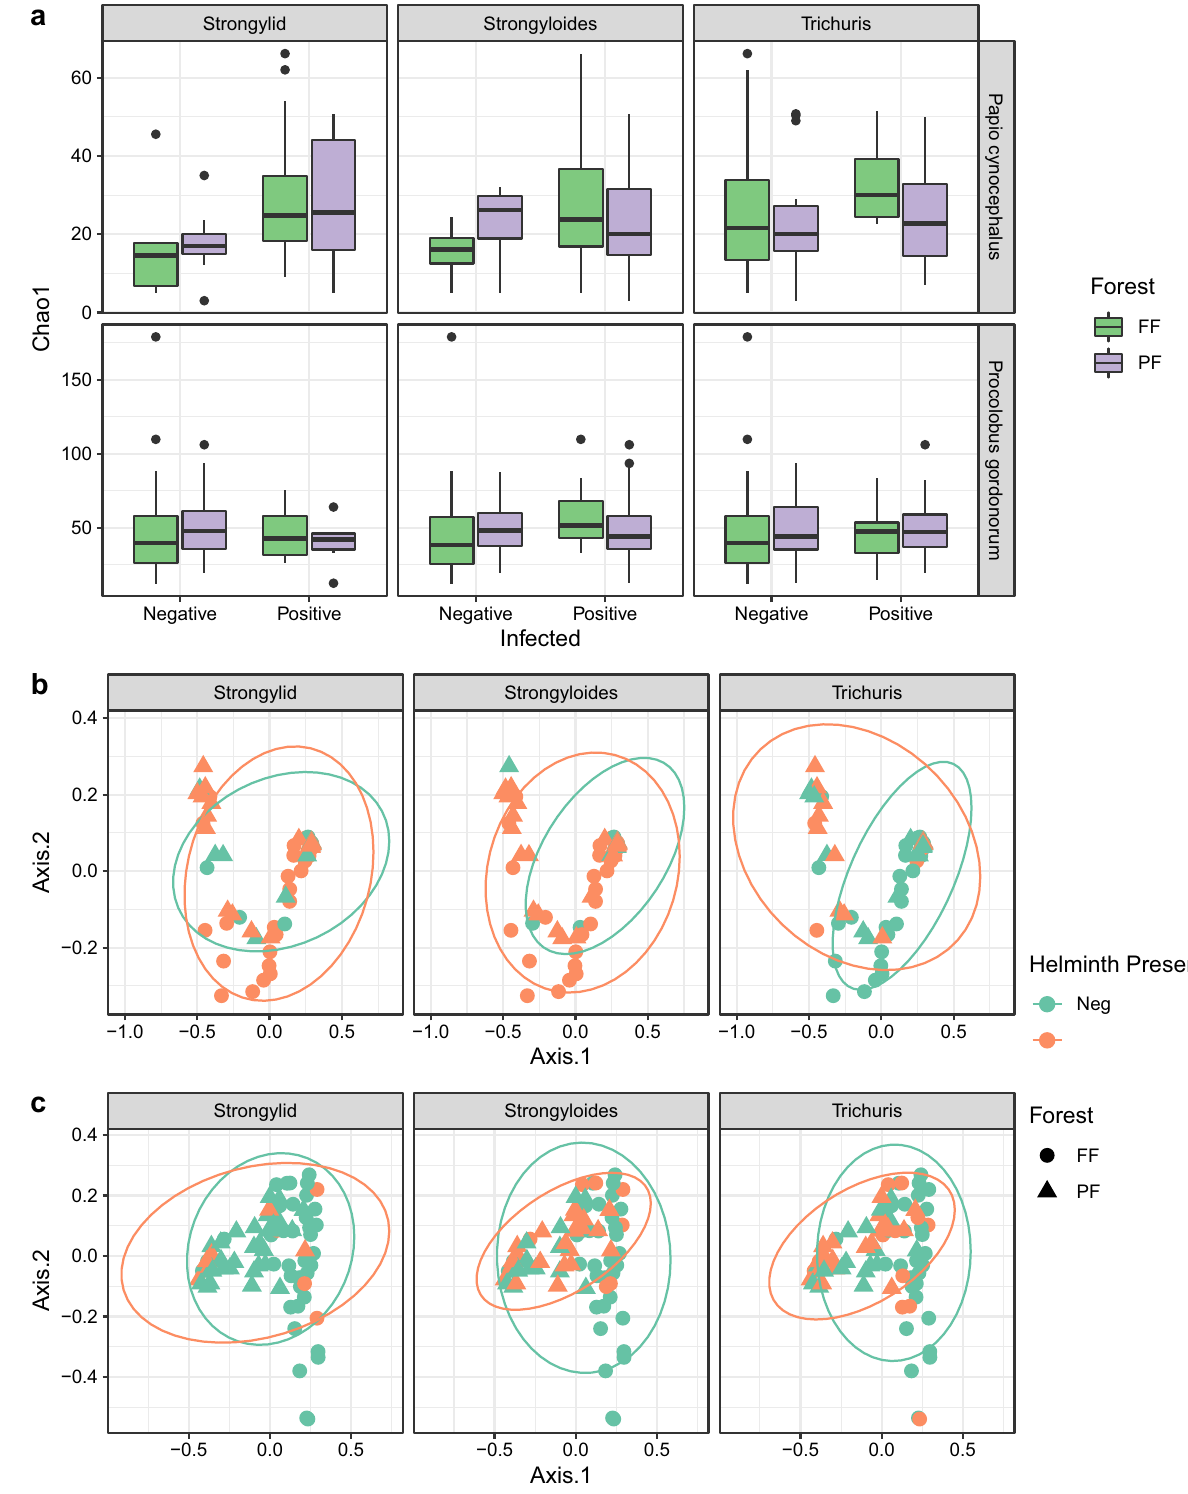
Figure 2. Diversity of gut fungal communities in yellow baboons and Udzungwa red colobus in different forest types. ( a ) Comparison of fungal richness measured by Chao1 estimator and ( b , c ) fungal composition measured by Bray–Curtis dissimilarities for helminth negative and positive faecal samples. Panels from left to right focus on three helminth taxa: strongylid nematodes, Strongyloides , and Trichuris present in yellow. In ( a ), the horizontal line in the boxplot indicates the median, the box extends to the 25th–75th percentile and the whiskers extends to the largest value no further than 1.5 * IQR from the hinges. In ( b ) and ( c ) colours represent helminth negative (green) and positive (orange)